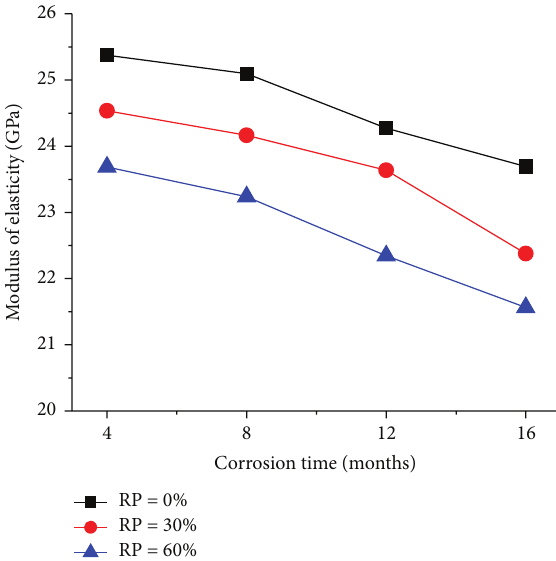
Figure 3: Elastic modulus of RAC with different corrosion